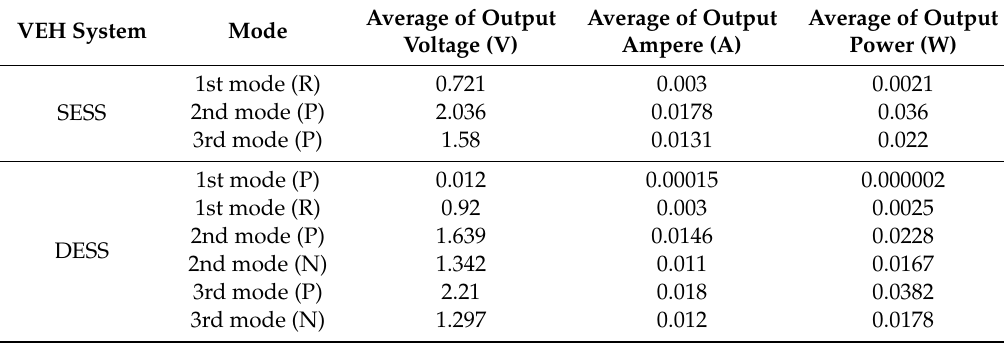
Table 4. Power benefits of the SESS and DESS systems, (R) represents piezo patch placed at the root, (P) represents piezo patch placed at the peak, (N) represents piezo patch placed at the node. VEH